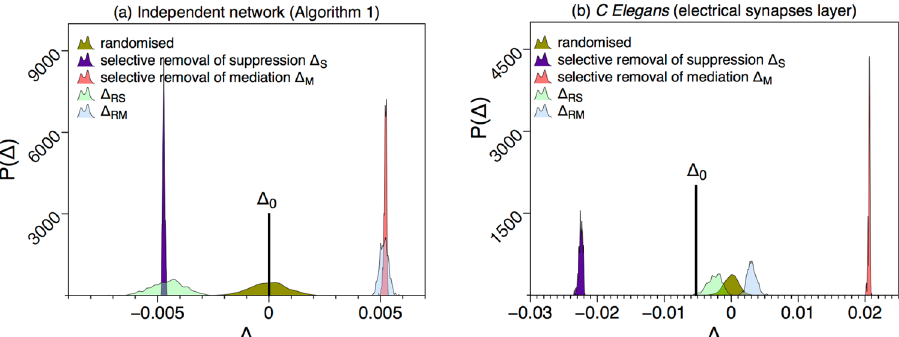
Fig. 4 Illustration of Algorithm 4. We illustrate the procedure of how to disentangle mediation and suppression in two examples. a Selective rewiring applied on a triplet of independent networks generated by Algorithm 1, with N = 300 nodes and P = 0.3 (these values are taken arbitrarily and chosen for illustration). The original value of the net Jaccard difference (close to zero) is denoted Δ 0 , which is close to zero according to an agreement with Theorem 2.1. Each selective rewiring is repeated 500 times, and histograms representing the distributions of the outputs across all realisations are built. The selective removal of suppression and mediation yields only a marginal change in the Jaccard net difference Δ , similar to the one performed on a randomised version, which indicates that the amount of suppression and mediation in this con fi guration is residual and only due to fi nite-size effects, as expected since C is independent of A ; B by construction. b Similar to a but applied on the C Elegans triplet, where network C is assigned to the electrical layer. The actual value Δ 0 < 0, initially suggesting mediation. The selective removal of suppression (mediation) signi fi cantly push the histograms towards more negative (positive) values of Δ — much more than such selective removal performed on randomisation — suggesting that there exist a signi fi cant amount of mediation and